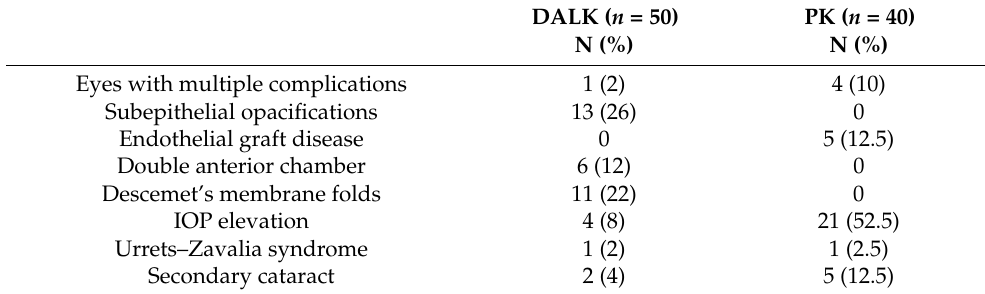
DALK, Deep Anterior Lamellar Keratoplasty; and PK, Penetrating Keratoplasty.